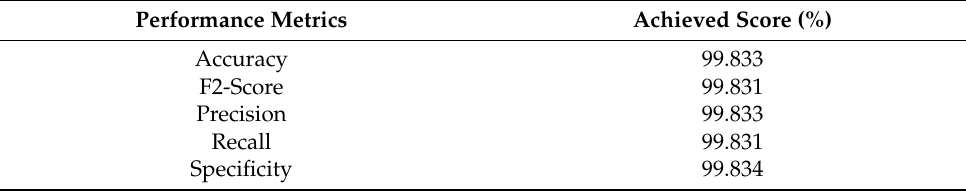
Table 5. Performance metrics of DenseNet169 for two-class